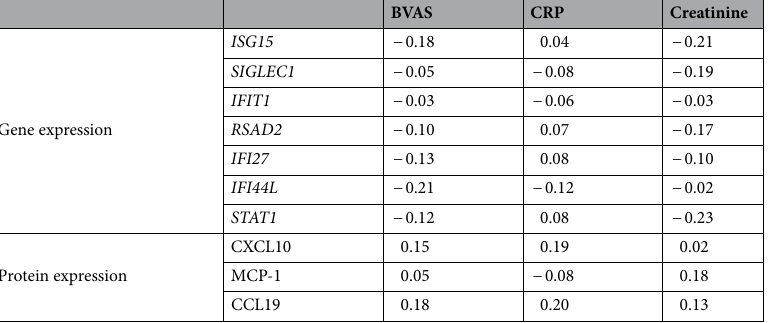
Table 3. Correlation of type I IFN responses with clinical measurements of AAV: Whole blood IRG gene expression data, as well as type I IFN regulated protein concentration data, collected from AAV patients (both active and remission) were correlated with matched BVAS, CRP and Creatinine levels. Spearman correlation analysis was used to generate correlation coefficient values, indicated in the table, and to determine the significance of these relationships. No statistically significant correlations were